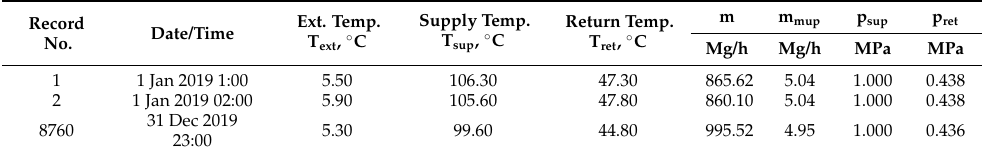
Table 1. Data record structure for